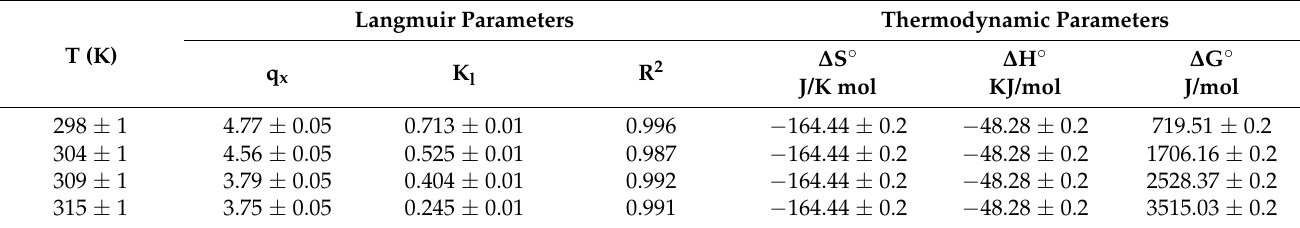
Figure 9. Langmuir model for copper ( a ) and zinc ( b ) ions. Dimensionless separation factor ( c ) and surface coverage ( d ) for the adsorption of both metal ions on modified chitosan. Table 2. Langmuir and thermodynamic parameters for copper.